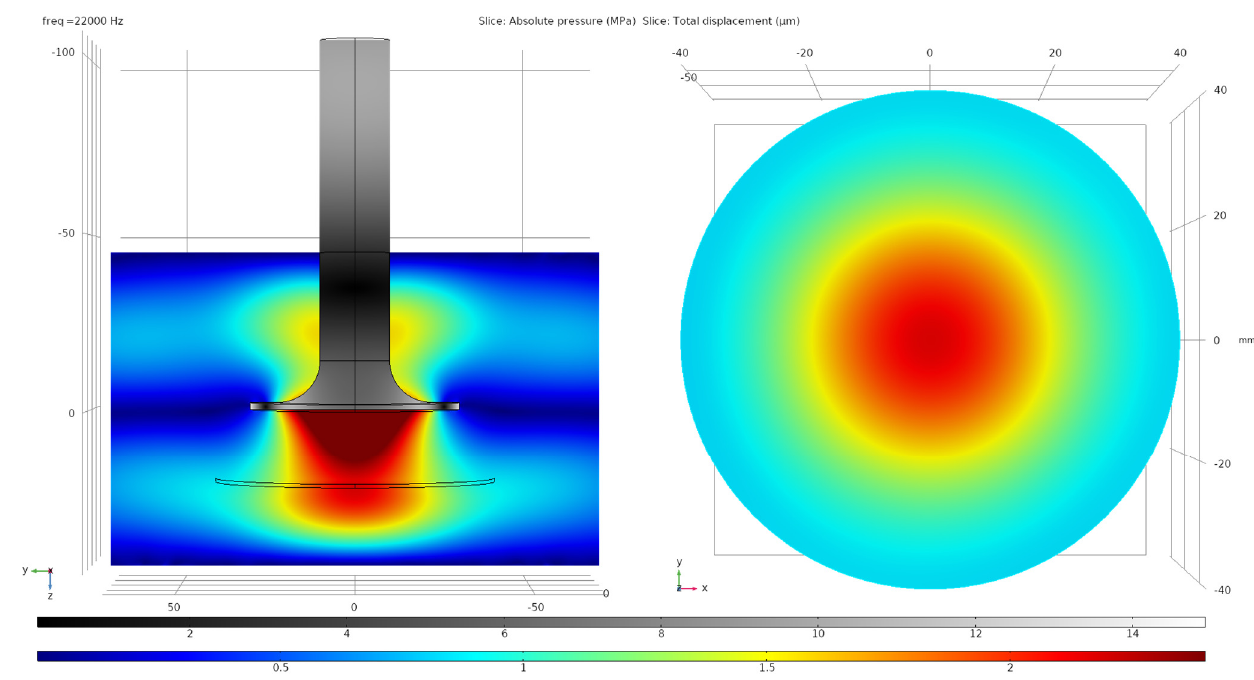
Figure 2. Calculations of the distribution of the amplitudes of longitudinal vibrations in the waveguide system and the acoustic pressures in the reaction vessel and on the surface of the processed cotton fabric.